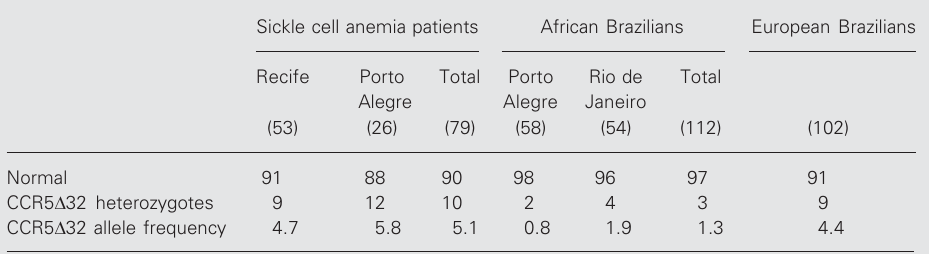
Table 1. Genotype and allele frequencies of the CCR5 gene in Brazilian sickle cell anemia patients and healthy individuals.